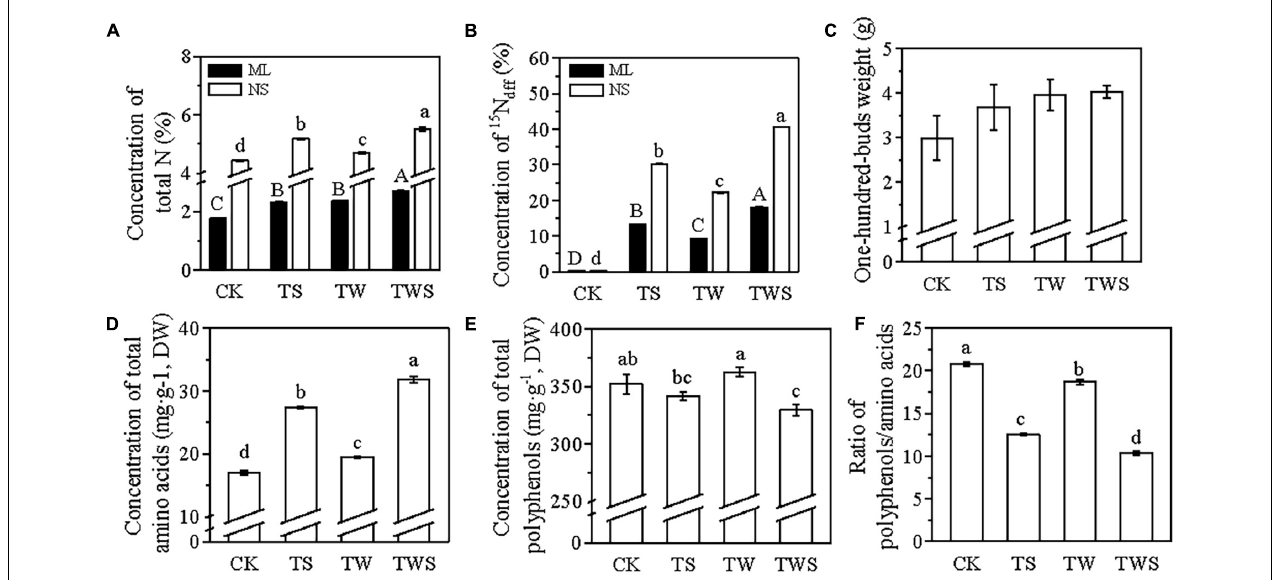
FIGURE 3 | 15 N-labeling pot experiment investigating the effects of foliar N application on tea plants at spring dormancy stage, winter dormancy stage, and both the spring and winter dormancy stage. 15 N-urea (2%, w/v) was sprayed on the tea plants two times at the winter dormancy stage (TW), two times at the spring dormancy stage (TS), or two times each at the winter or spring dormancy stage (TWS), no application of 15 N-urea was used as control (CK). ML, mature leaves (black bars); NS, new shoots (white bars); 15 N dff , 15 N derived from the foliar 15 N-urea; DW, dry weight. Data represented mean ± SE; n = 3 in panels (A,B) , 5 in panel (C) , 9 in panel (D) , 6 in panel (E) , and 3 in panel (F) . Lowercase letters indicated the significant differences of NS, while capital letters presented the significance of ML ( P < 0.05; ANOVA, followed by the Duncan test).